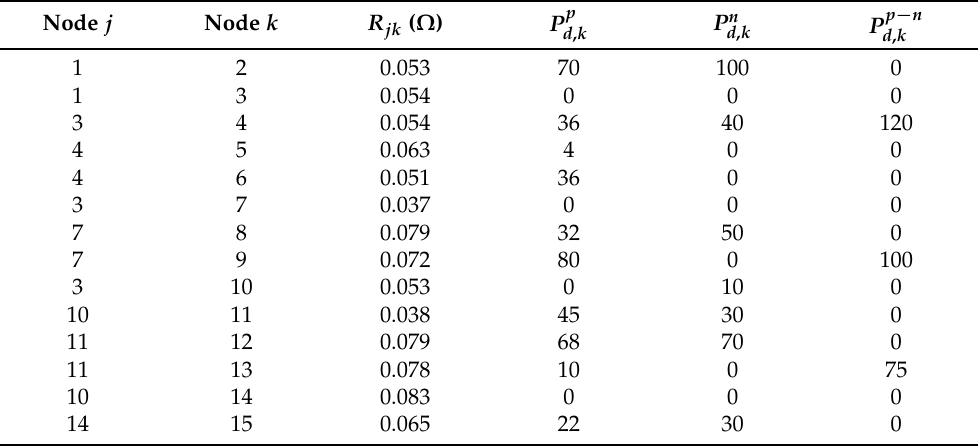
Table 1. Data for the 21-bus system (all powers in